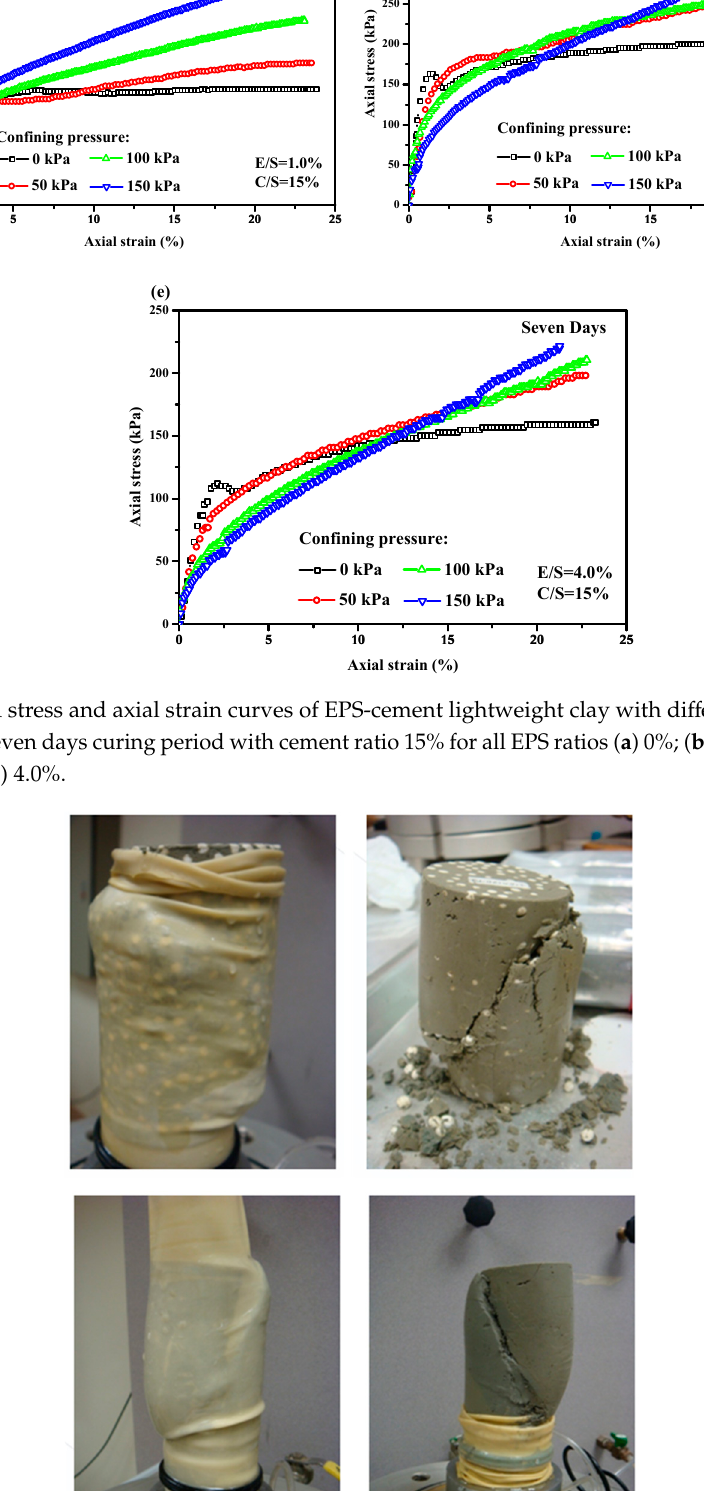
Figure 10. Elastoplastic failure for the higher E/S ratio. 3.3. Compressive Strength Versus Failure Strain The relationship between compressive strength